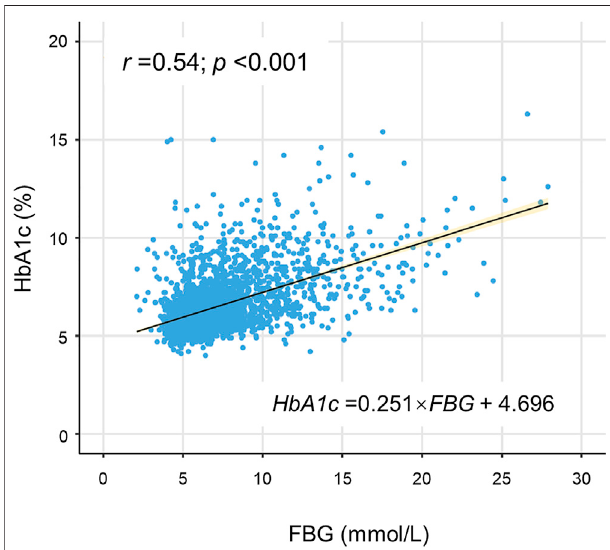
FIGURE 2 | Correlation of FBG with HbA1c. A statistically signi fi cant positive association was shown between FBG and HbA1c in the scatterplot. The solid line was the linear regression fi tted line, while the yellow shadow aroundthelineindicated95%con fi denceintervaloftheregression.FBG indicates fasting blood glucose; HbA1c, glycated